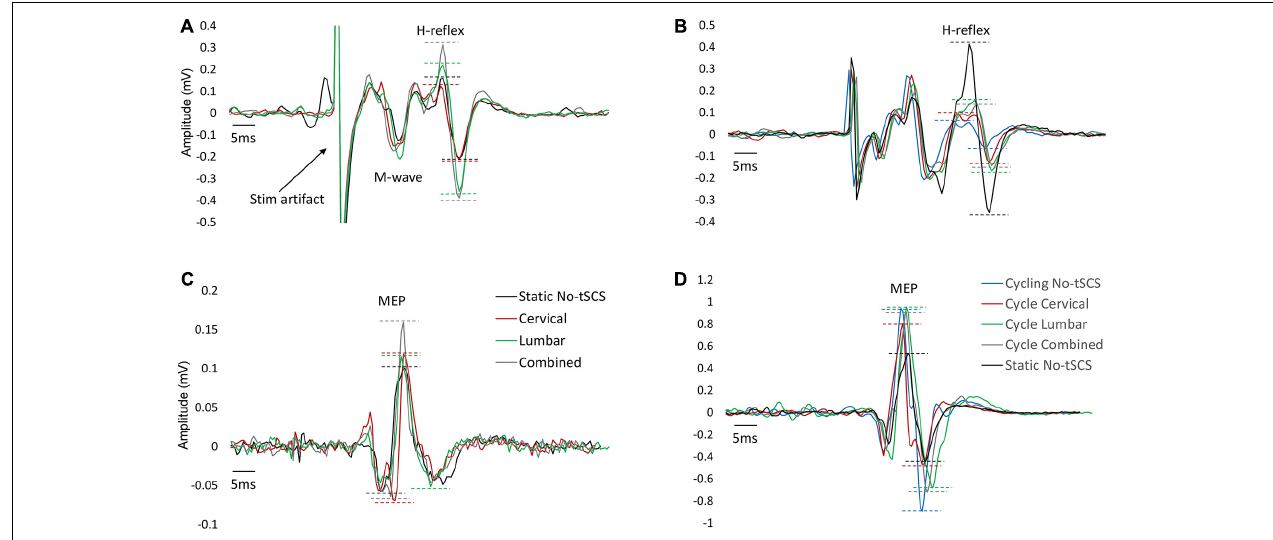
FIGURE 5 | Typical FCR H-reflex and MEP traces across conditions. An example of FCR H-reflex and MEP responses from one participant across all conditions. (A) Changes in H-reflex amplitude with Cervical, Lumbar and Combined tSCS compared to No-tSCS while the legs were held static. (B) Suppression of H-reflex amplitude across all cycling conditions compared to legs static, No-tSCS. (C) Changes in MEP amplitude with Cervical, Lumbar and Combined tSCS compared to No-tSCS while the legs were held static. (D) Increase in MEP amplitude across all cycling conditions compared to legs static, No-tSCS.